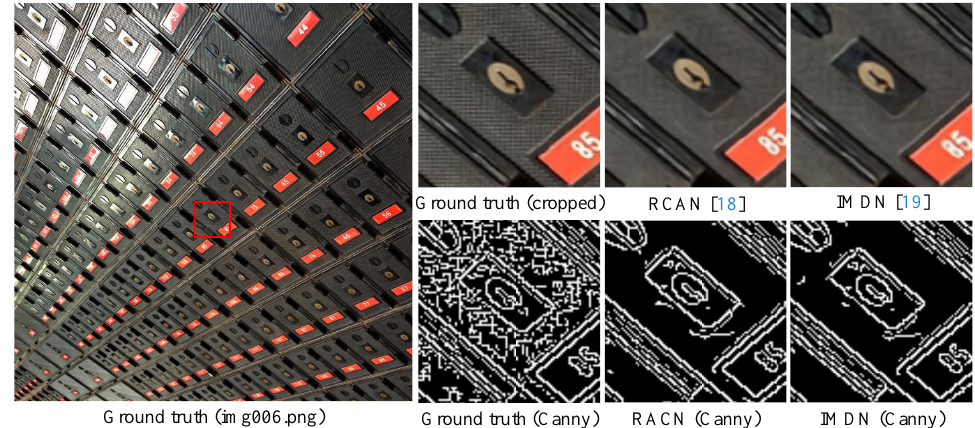
Figure 6. Ground truth/SR images and their edge images extracted by Canny